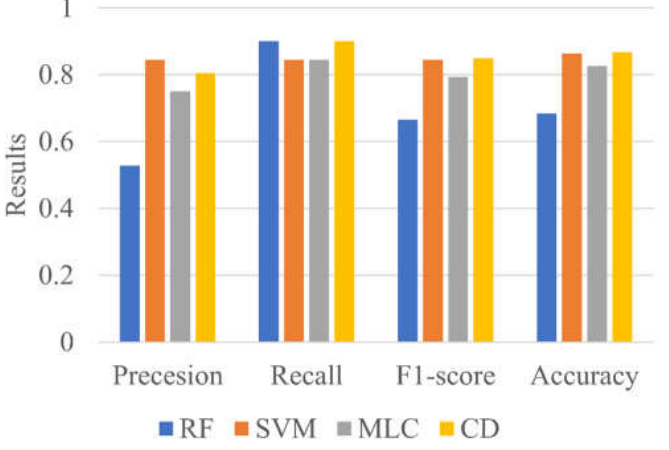
Figure 5. The model performance metrics of four different machine learning models in terms of precision, recall, F1 score and